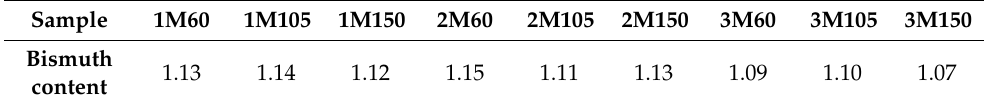
Table 2. Bismuth content in